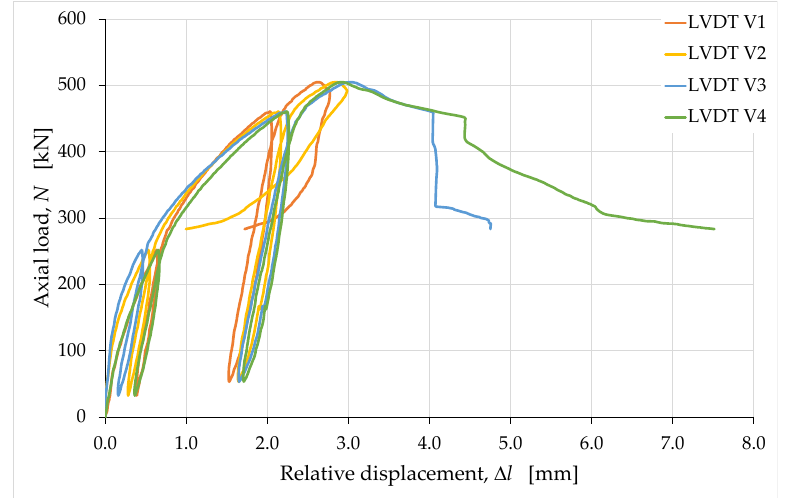
Figure 9. Load/displacement curves acquired along the vertical edges of the specimen.